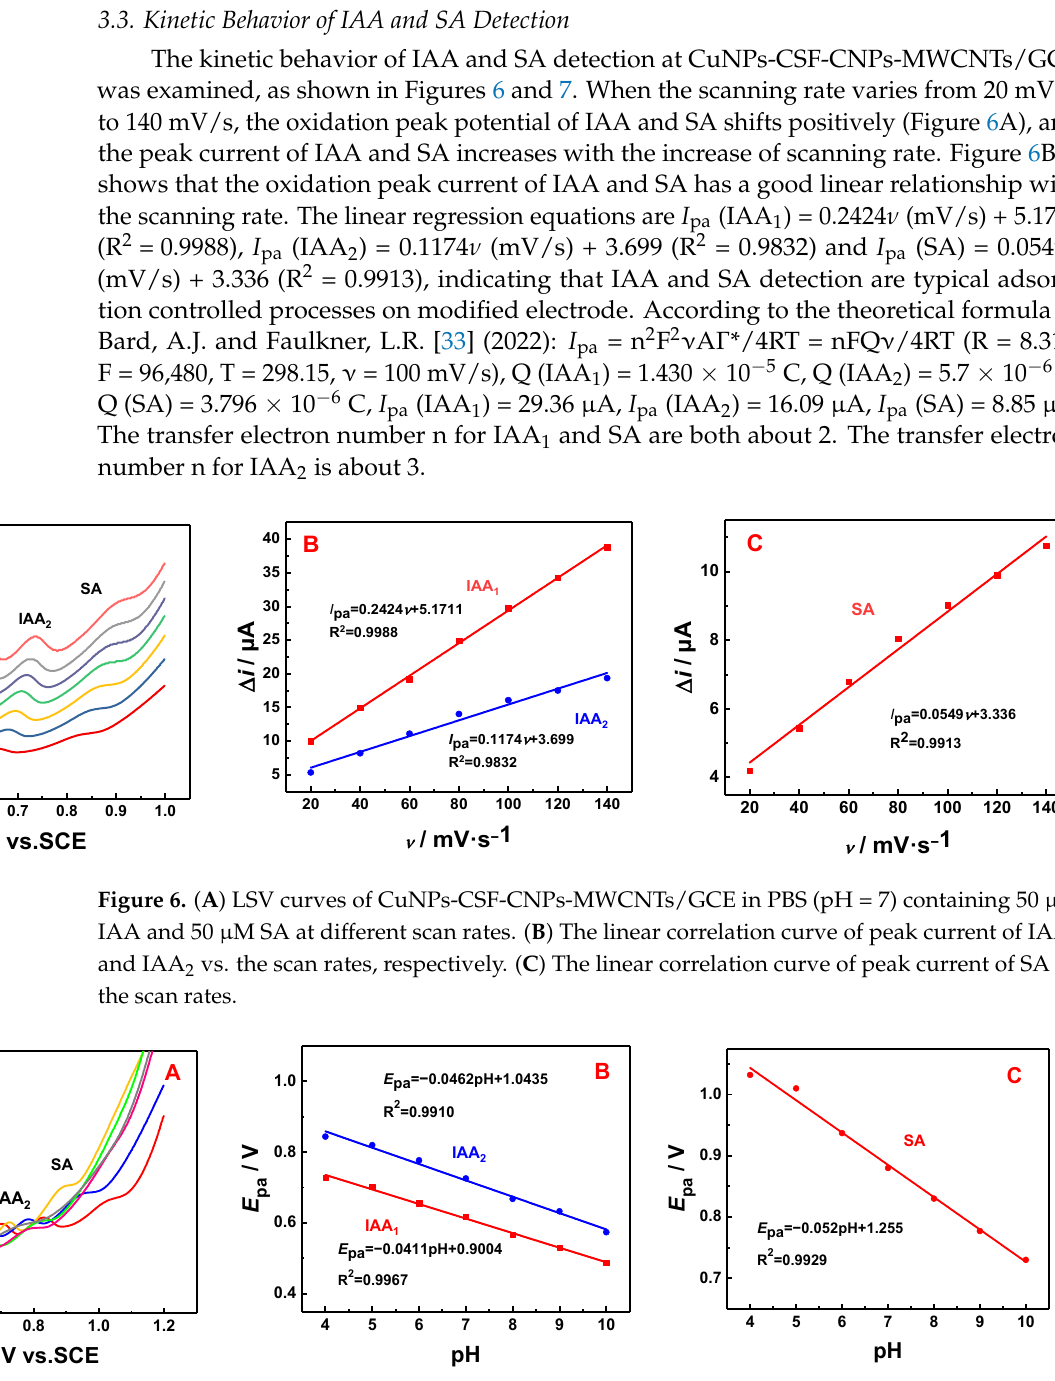
Figure 7. ( A ) LSV curves of CuNPs-CSF-CNPs-MWCNTs/GCE in PBS containing 50 μ M IAA and 50 μ M SA at different pH values. Scan rate is 100 mV/s. ( B ) the linear correlation curve of E pa of IAA 1 and IAA 2 vs. pH. ( C ) The linear correlation curve of E pa of SA vs. pH.